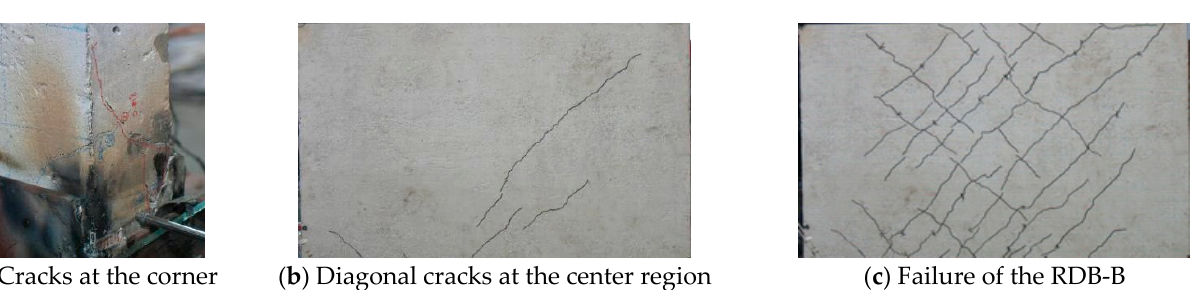
Figure 6. Failure modes of the RDB-B.